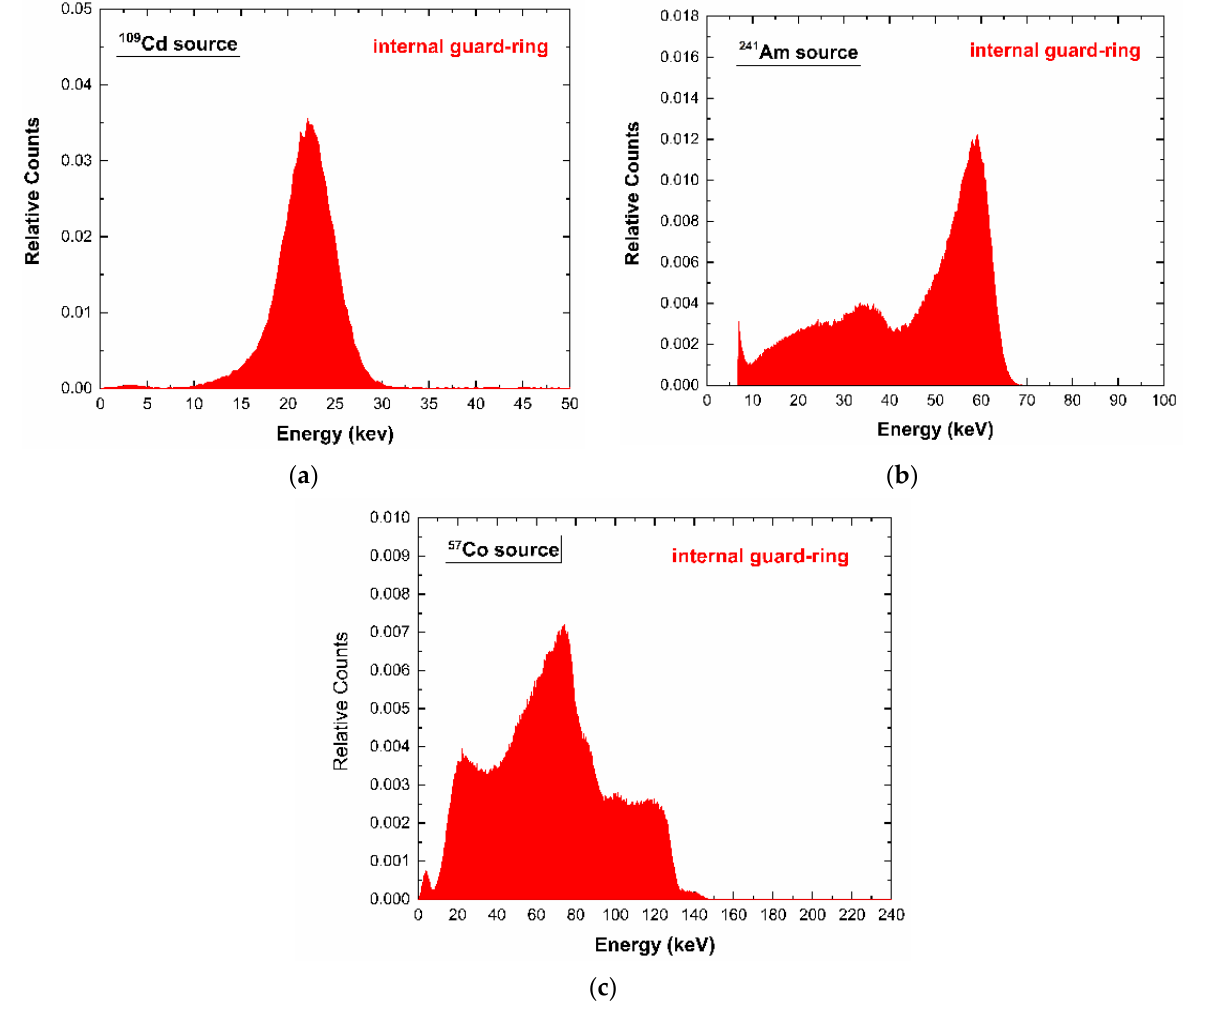
Figure 6. ( a ) 109 Cd, ( b ) 241 Am, ( c ) 57 Co energy spectra of the internals guard-ring.